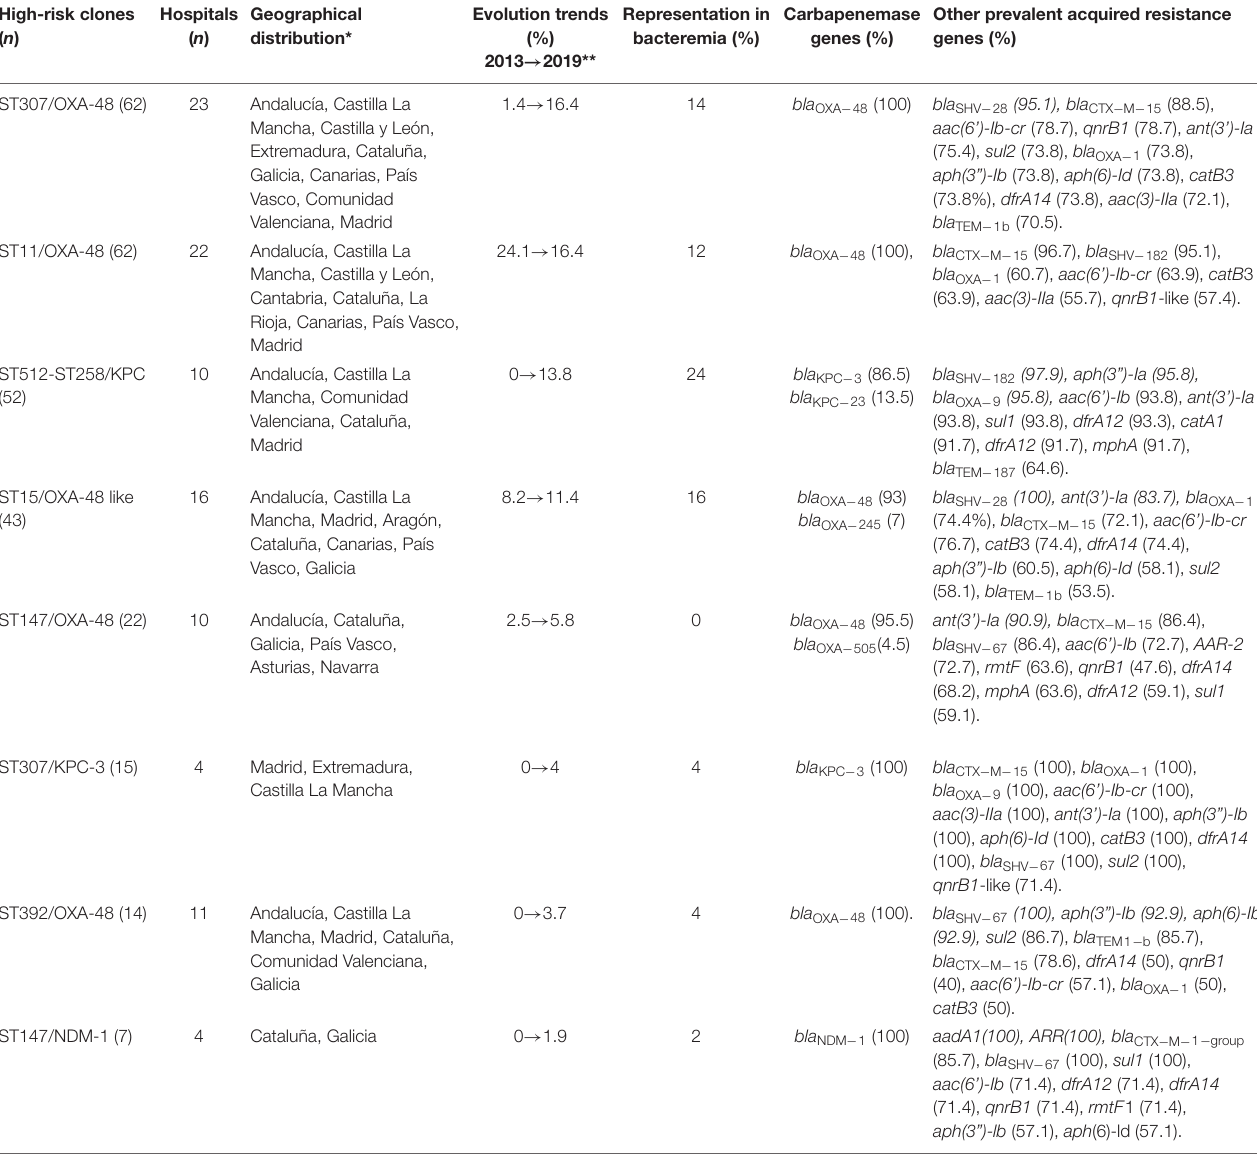
TABLE 2 | High-risk carbapenemase-producing Klebsiella pneumoniae clones defined according to combinations of sequence type/carbapenemase. High-risk clones Hospitals Geographical ( n ) ( n ) distribution*